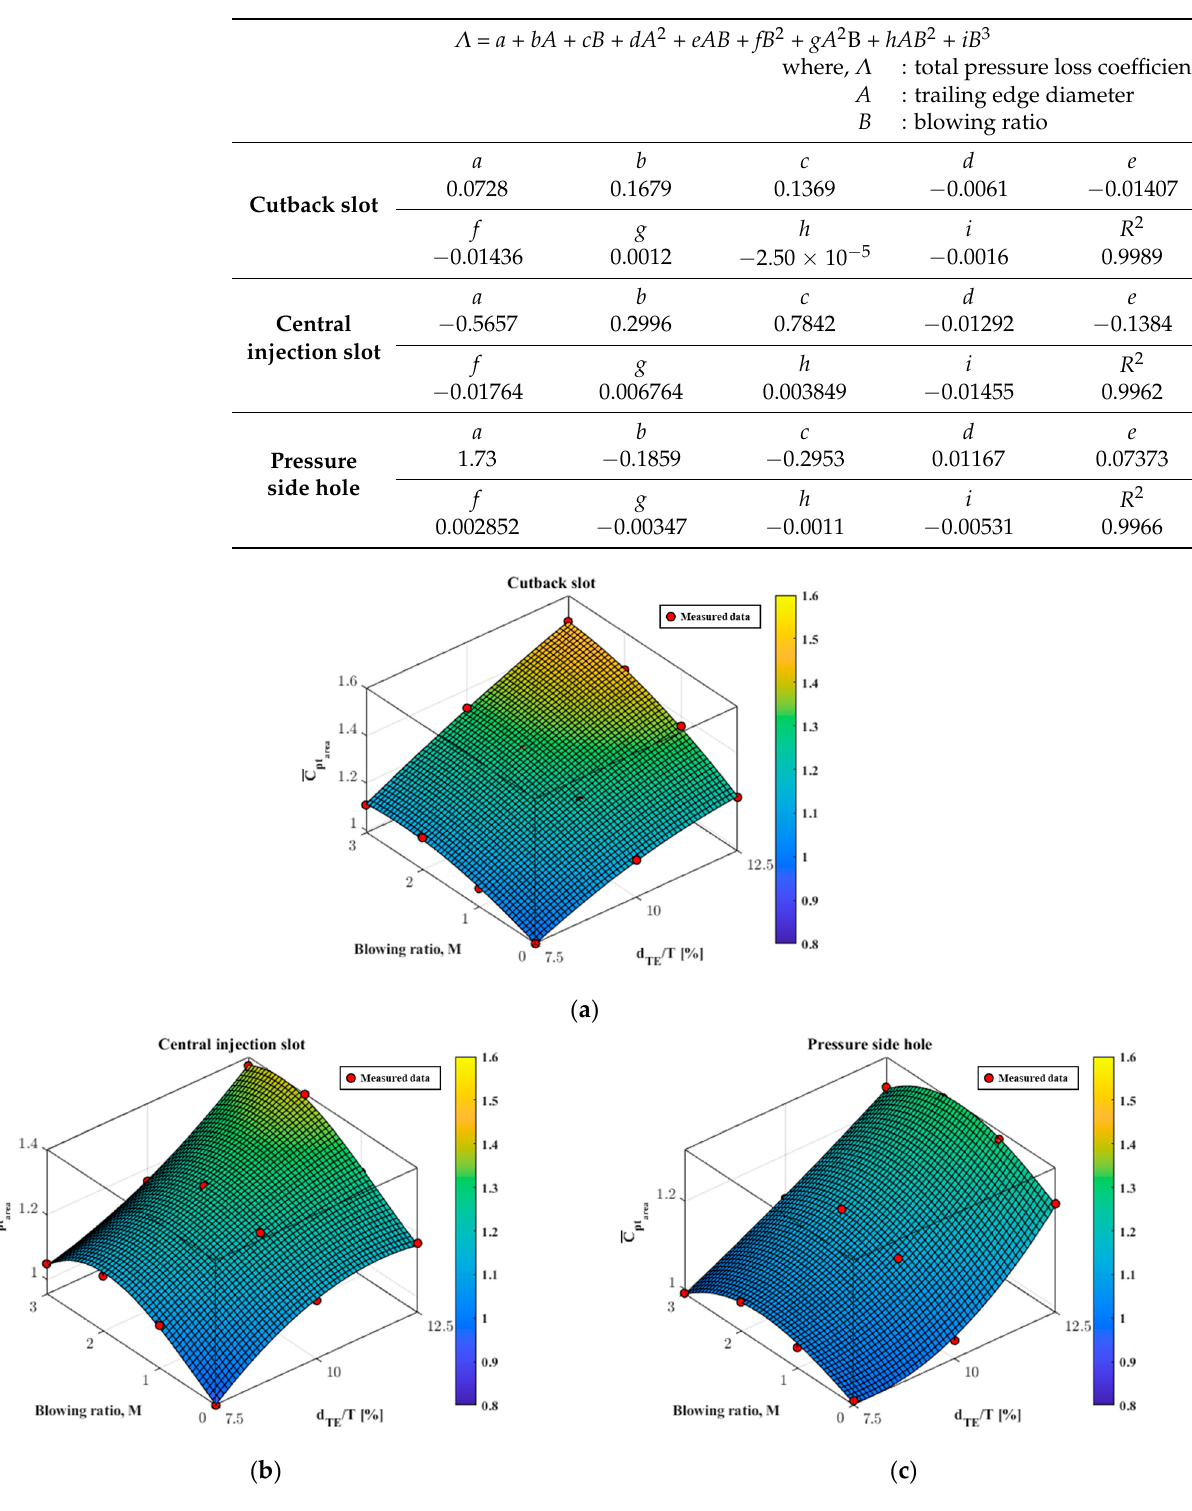
Figure 12. 3D contours of correlation equations for each cooling scheme: ( a ) cutback slot; ( b ) central injection slot; ( c ) pressure side hole.